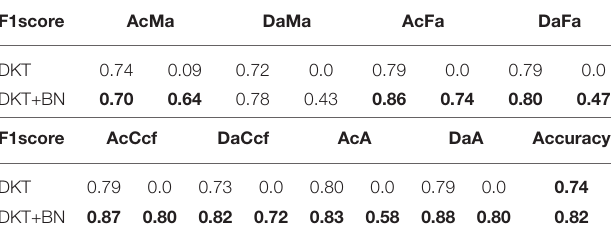
TABLE 2 | The DKT and the DKT+BN on skills that are difficult to master. F1score